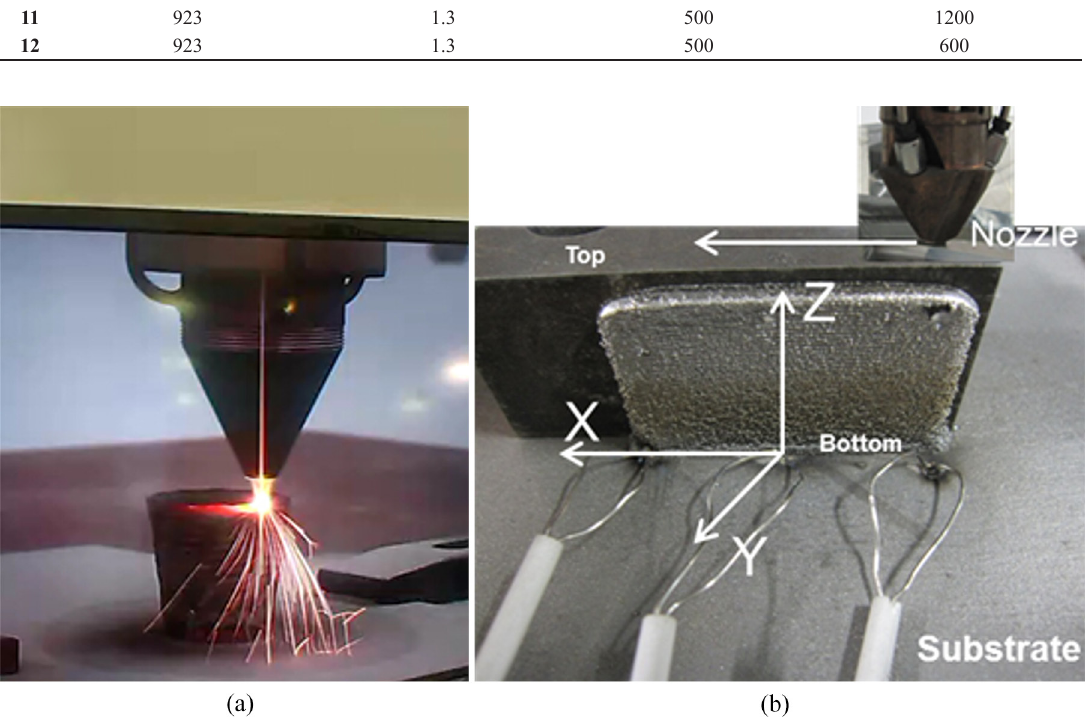
Figure 1. The experiment process and the examples of different shaped components (a) cylinder (b) thin